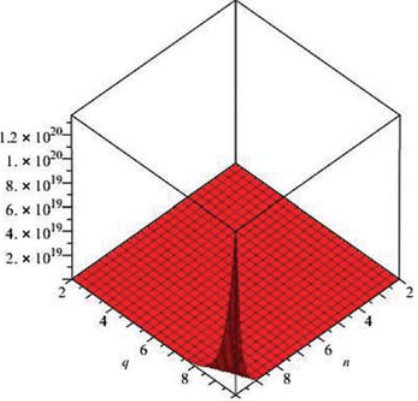
Figure 11: Plot of M